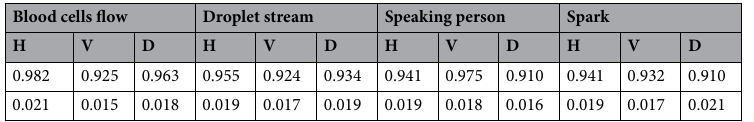
Table 2. Correlation analysis of adjacent pixels in horizontal, vertical and diagonal